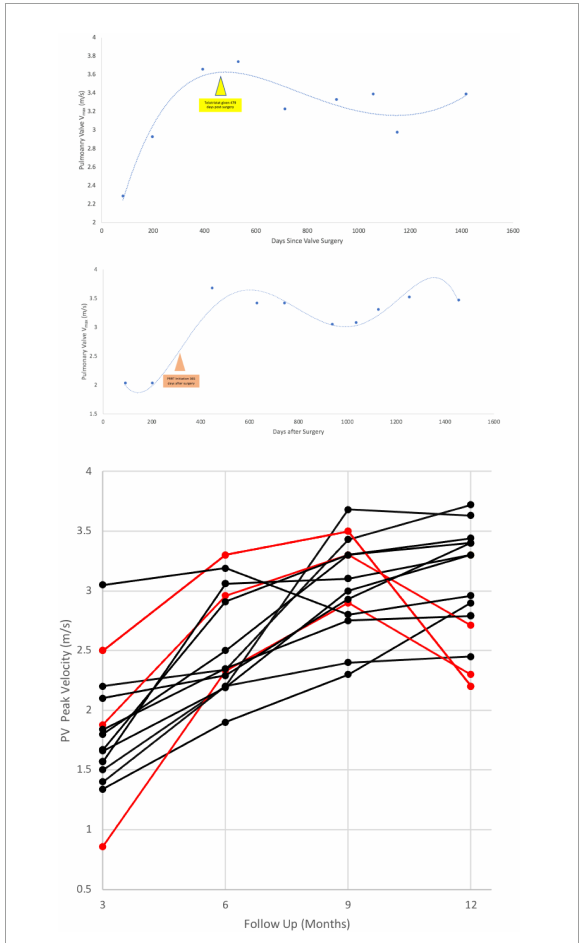
FIGURE3 An example of an perioperative rise in pulmonary valve peak velocity after heart surgery in a patient with bioprosthetic TV + PV replacement (Top, Middle) . Bottom shows the effect of telotristat ethyl treatment with or without peptide receptor radionuclide therapy on post-surgical pulmonary valve velocities. Time 0, x-axis, is at 3 months post-op. Red lines are patients’ PV velocities who were given advanced therapies (telotristat ethyl, PRRT) in this post-operative timeframe. PRRT, peptide receptor radionuclide therapy; V max , peak